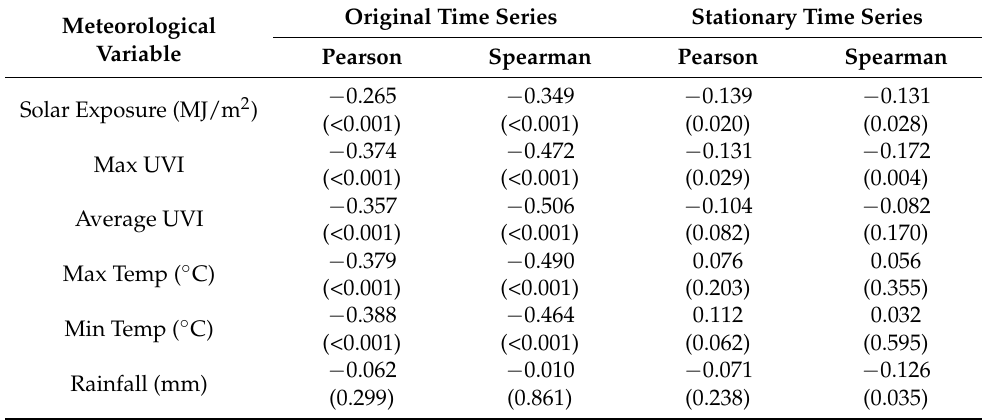
Figure 2. Original time series of the daily confirmed cases ( a ) and six meteorological variables ( b ) solar exposure; ( c ) maximum and minimum temperature; ( d ) maximum and average UVI; ( e ) rainfall. Table 2. Pearson and Spearman correlation coefficients between the daily confirmed cases and six meteorological variables for the original and stationary time series with the corresponding p-value.